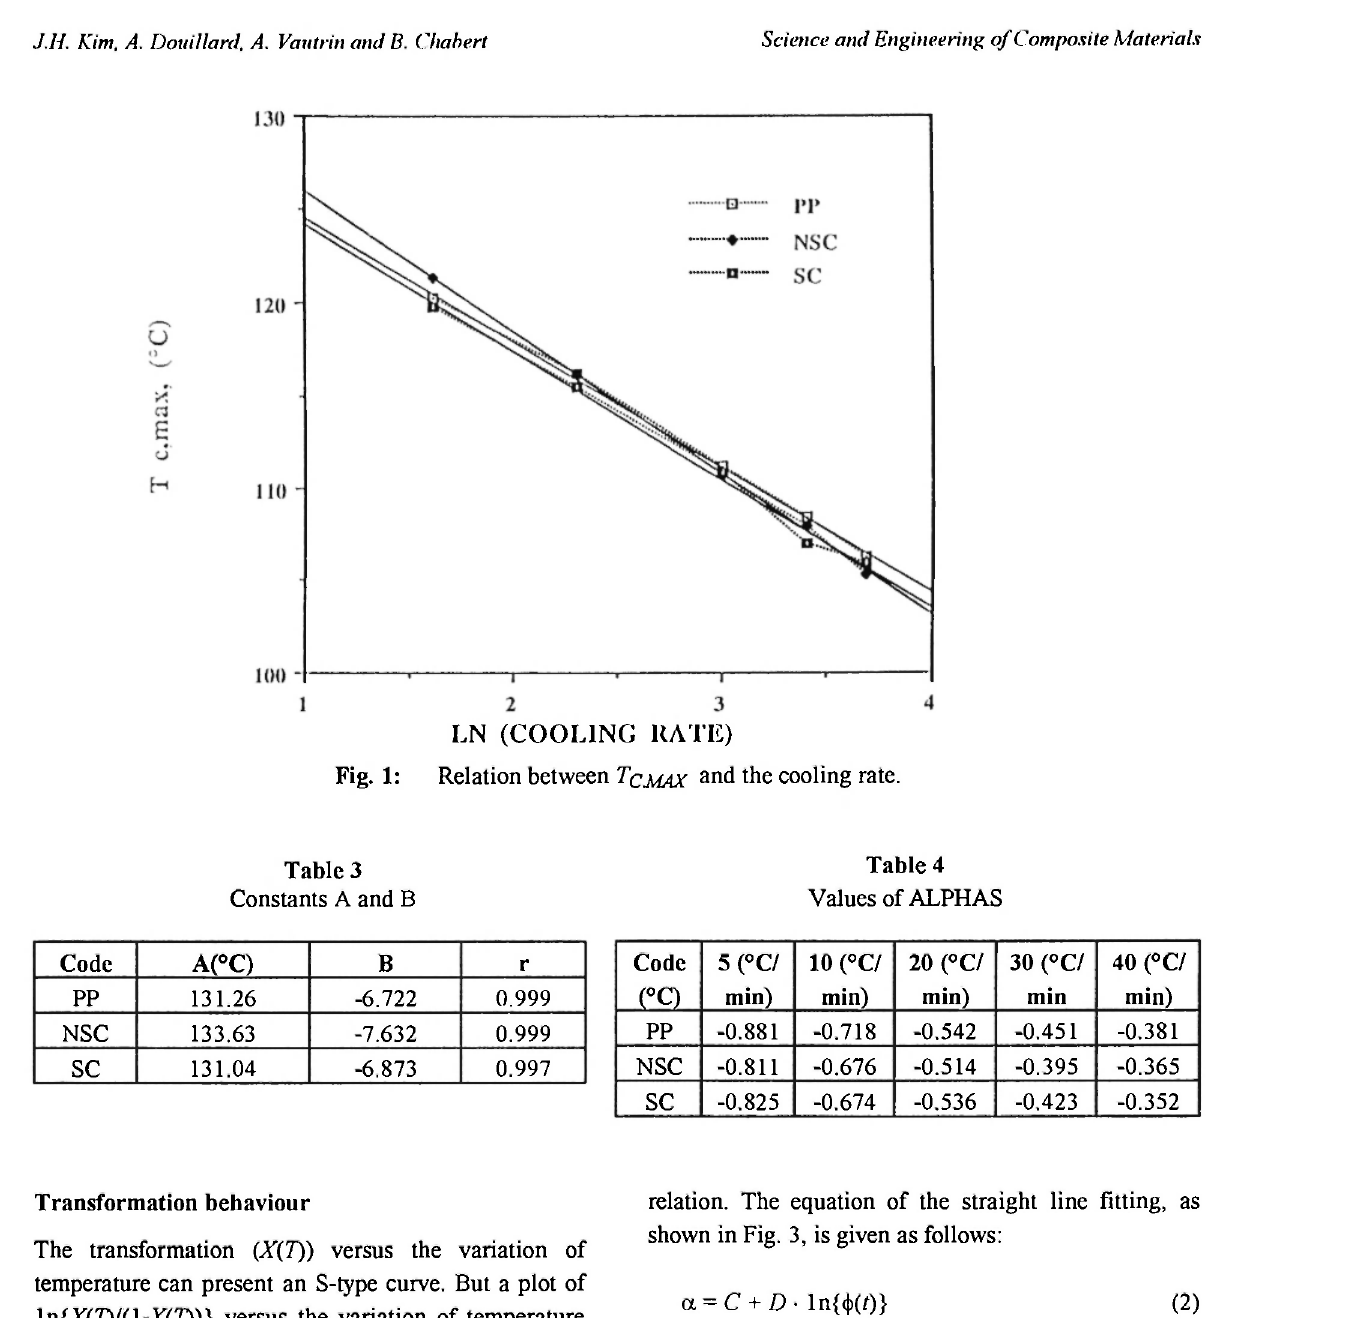
Fig. 1: Relation between TQMAX an d the cooling